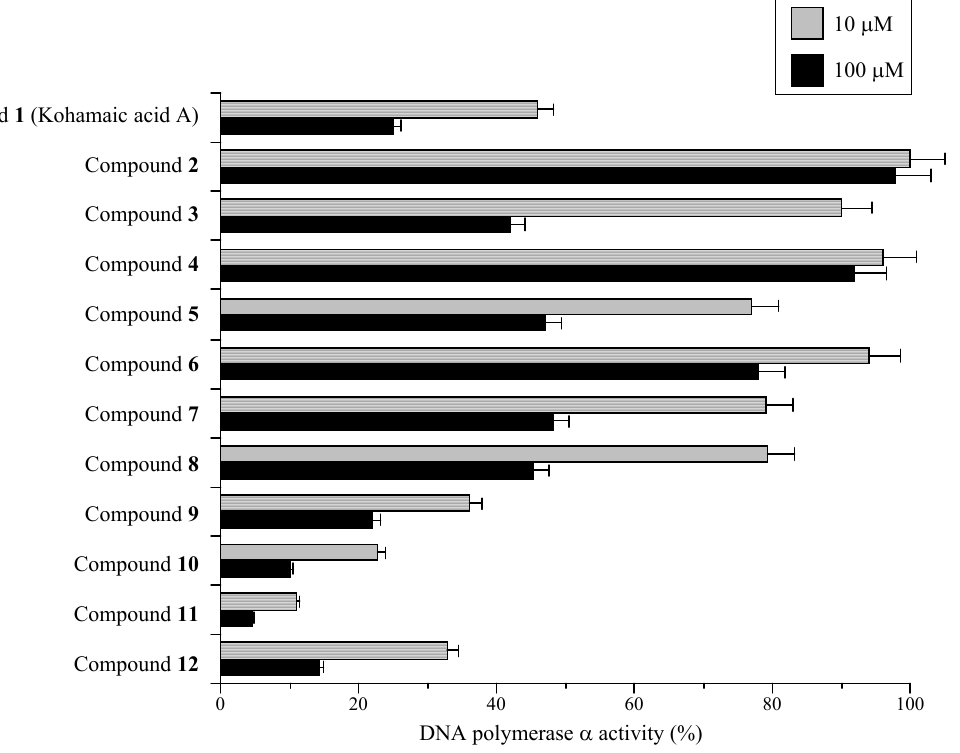
Figure 2. Effects of kohamaic acid A derivatives (compounds 1 – 12 ) on the activities of mammalian DNA polymerases α and β .